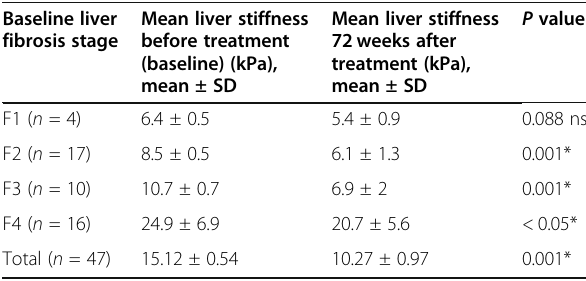
Table 5 LSM before and 72 weeks after SMV/SOF therapy in SVR